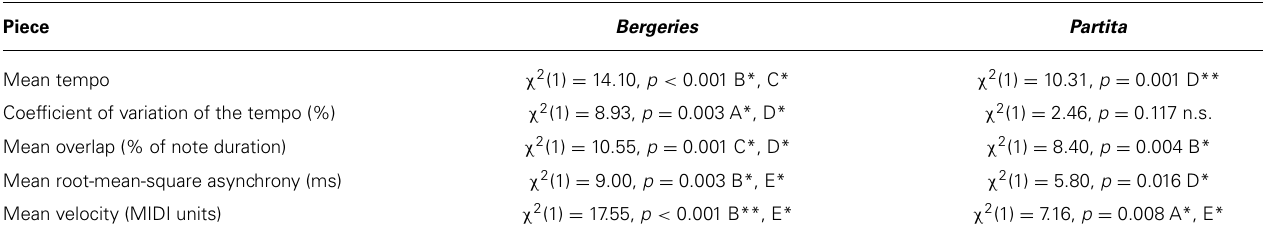
Table 2 | Mixed-models analyses of variance on the expressive parameters. Piece Bergeries Partita Mean